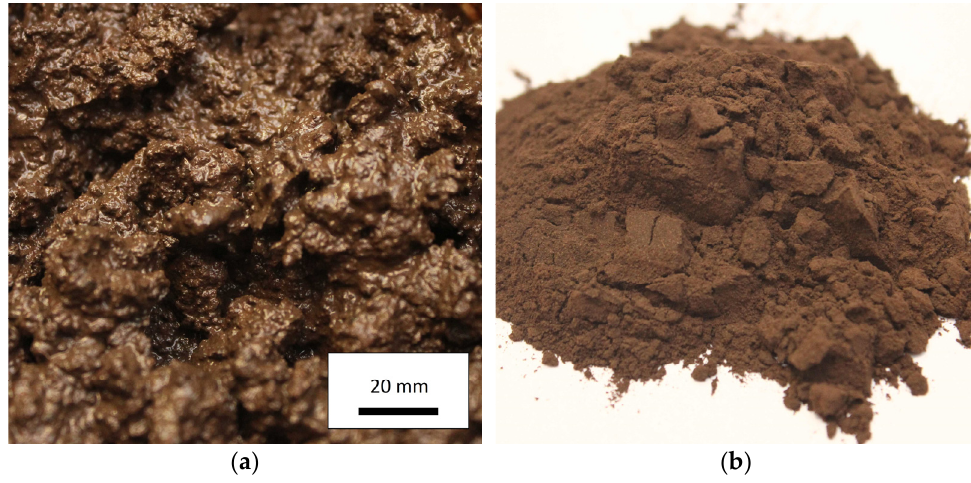
Figure 1. The SAR in the wet state (as delivered) ( a ) and dry state ( b